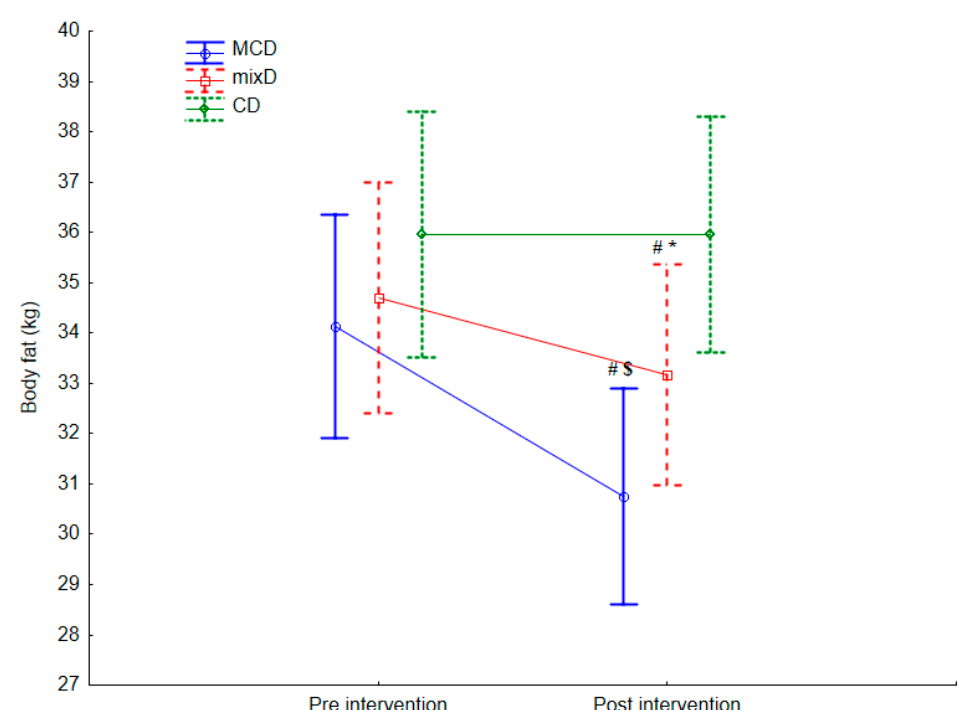
Figure 3. Differences in body fat weight (kg) postintervention between the moderate-carbohydrate diet (MCD), mix diet (MixD), and conventional diet (CD). Values are expressed as mean and standard deviation. (CD) groups; #—significant difference compared with the baseline, $—significant differences compared with the MixD and CD groups, respectively ( p < 0.05), *—significant difference compared with the CD groups.